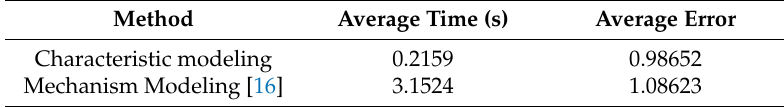
Table 2. The comparison of consuming time between different modeling